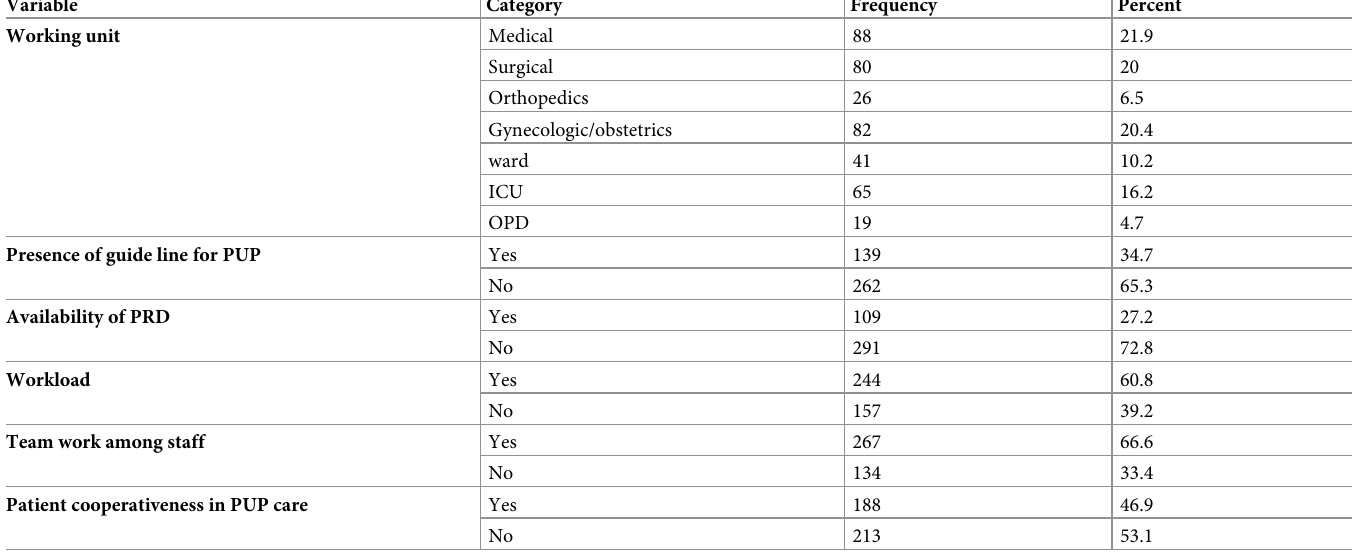
Table 2. Work environment and patient related characteristics of study participants in public hospitals of Harari regional state and Dire Dawa city administration, Eastern Ethiopia, 2018 (n = 401). Variable